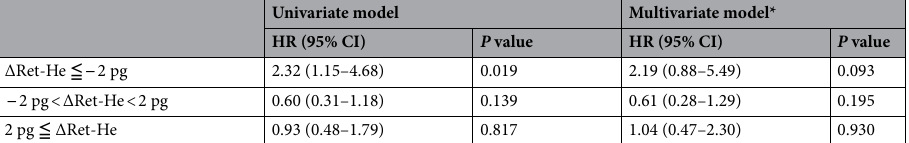
Table 3. Univariate and multivariate Cox regression analysis for composite outcomes. *Model adjusted for age, male, body mass index at discharge, brain natriuretic peptide levels at discharge, the prevalence of atrial fibrillation, and the use of Ca blockers. ΔRet-He the change of Ret-He levels between admission and discharge, HR hazard ratio, CI confidence interval.